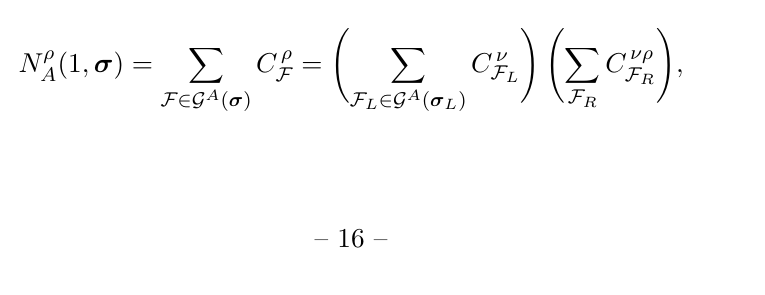
, which involves trees T R